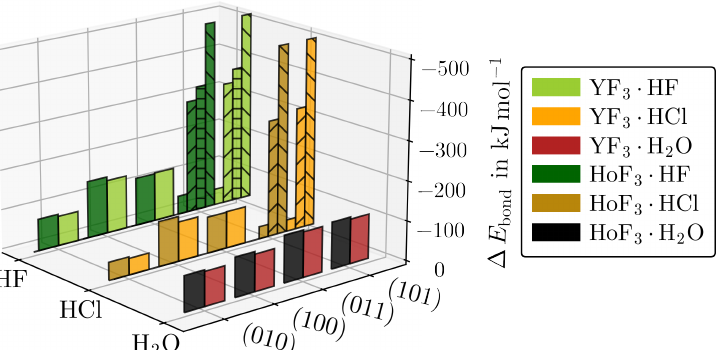
Figure 3. ∆ E bond for the respective strongest adsorptions of YF 3 · Ads and HoF 3 · Ads for each ( hkl ) and adsorbate. The hydride-forming adsorptions of (101) · H F/Cl (upward stripes), (101) · H F 3Å 3.5Å (horizontal stripes), or (101) · H F/Cl (downward stripes) are given separately. 7Å The most striking variation in adsorption energies is found along ( hkl ) · HF and ( hkl ) · HCl. The differences between the respective strongest adsorptions onto the same MF 3 ( ∆∆ E Cl − F ) according to Equation (4) are depicted in Figure 4. bond